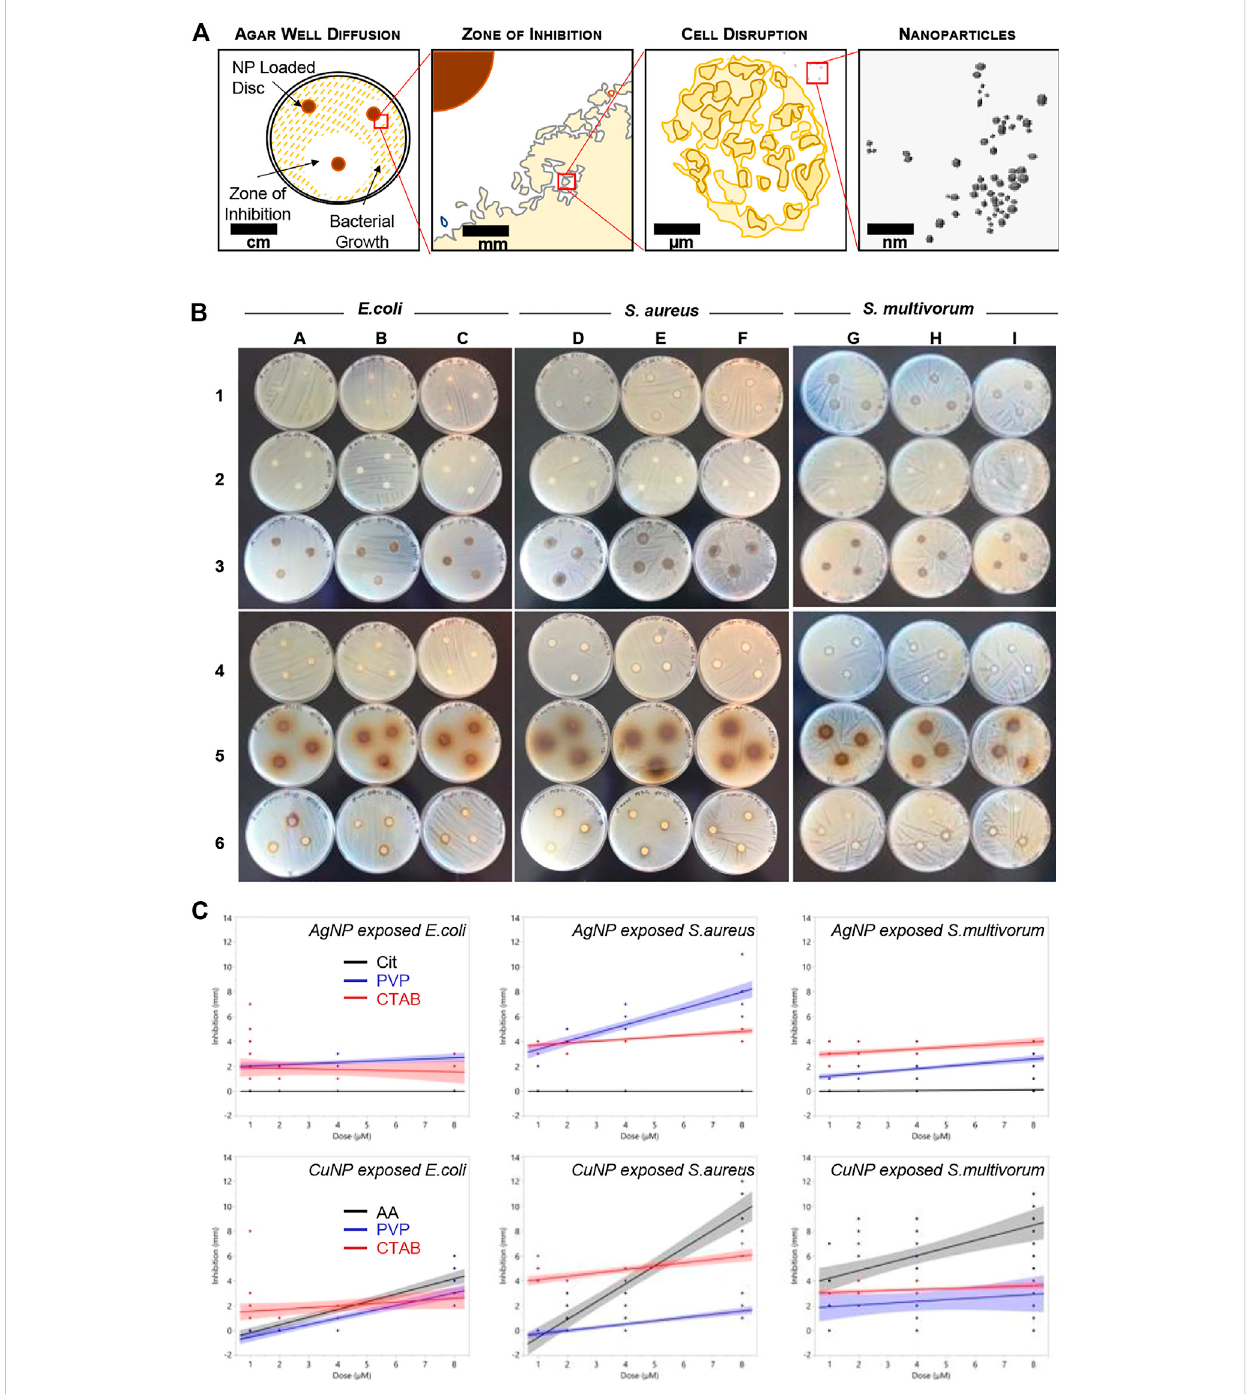
Bacterialgrowth inhibitionresultingfromnanoparticleexposure. (A) Schematic representing thediscdiffusionmethodanalyses. (B) Photographsof the disc diffusion results. (C) Quantitative representation of the photographs. Plots show inhibition (measured in mm) induced in Escherichia coli , S. aureus , and S. multivorum . Blue dots indicate measures of inhibition from Cit-AgNPs (top row) and AA-CuNPs (bottom row), red dots indicate measures fromPVP-AgNPsandPVP-CuNPs, and blackdotsindicate measuresfromCTAB-AgNPsandCTAB-CuNPs. Linesindicate thebest fi tregressionand shaded areas represent the 95% con fi dence